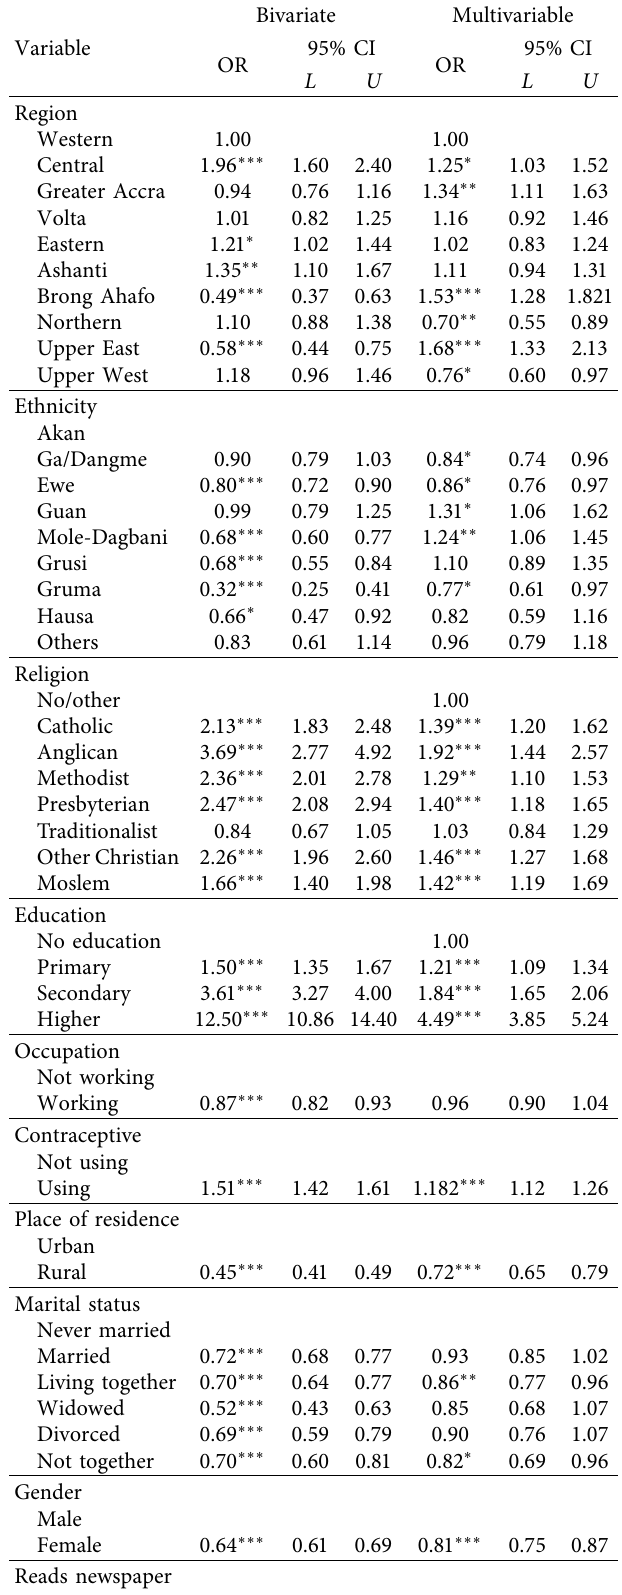
Table 3: CK of HIV and AIDS among Ghanaians (pooled